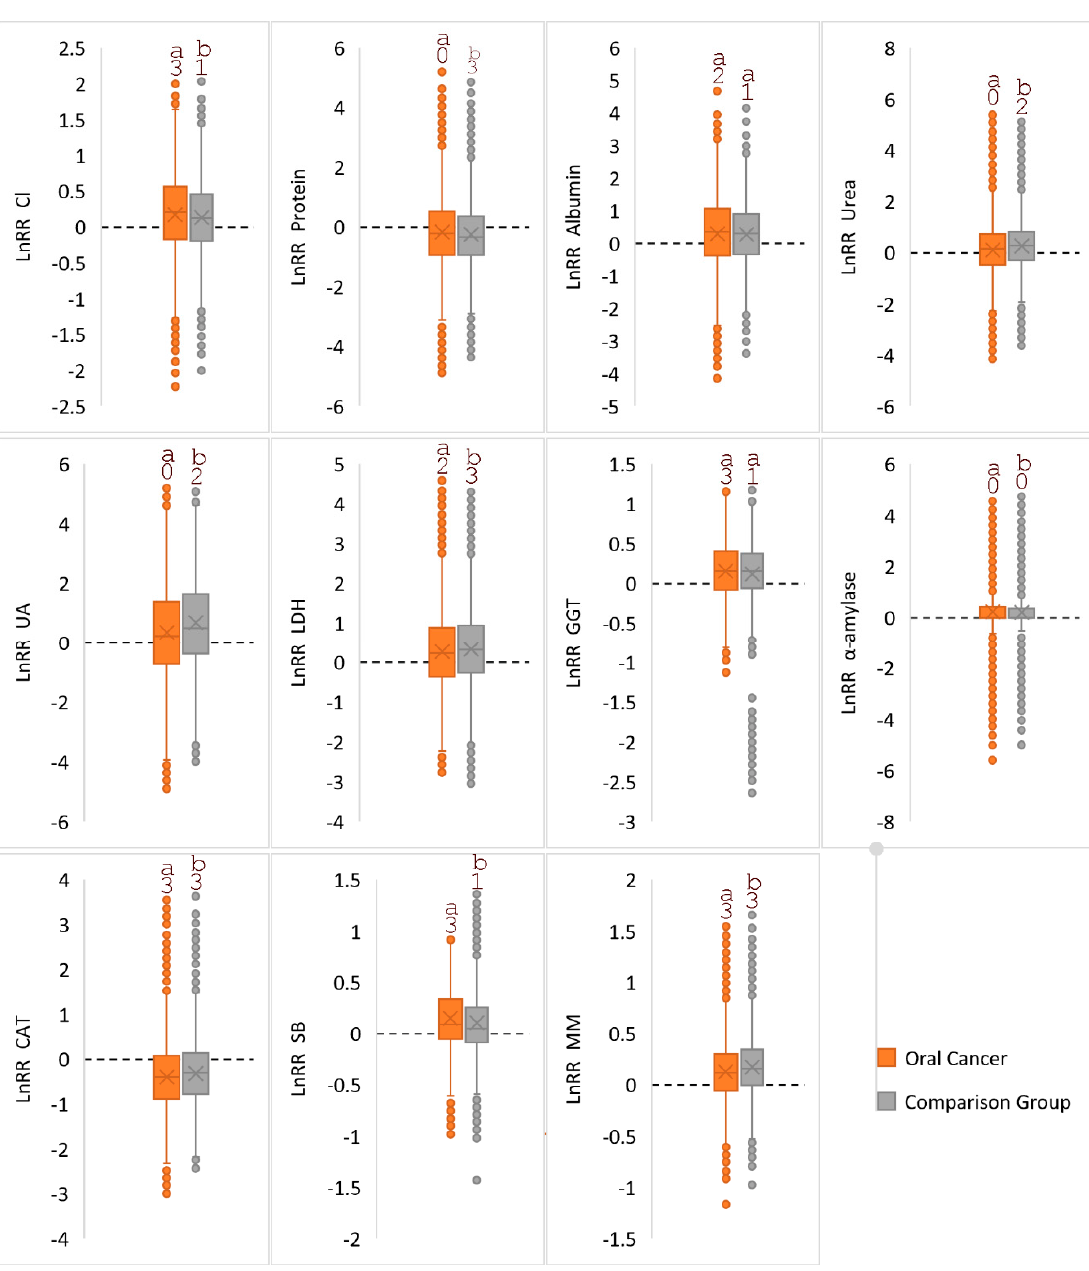
Figure 3. The intensity of the difference ( Ln RR = Ln (OSCC/Control) and Ln RR = Ln (Comparison/Control)) by 11 biochemical parameters from the control group . Similar letters do not differ much ( α = 0.05). The dashed line represents the zero level ( Ln RR = 0). Significance of differences from 0 was checked using the t-test of one sample and indicated by numbers (“0” is not significant; “1” is p < 0.05; “2” is p < 0.01; “3” is p < 0.001).